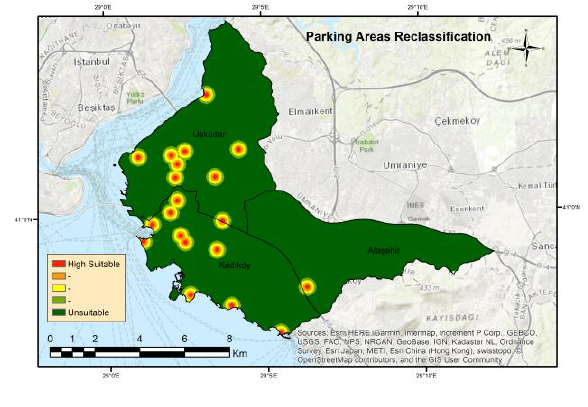
Figure 4. Distance to parking areas map